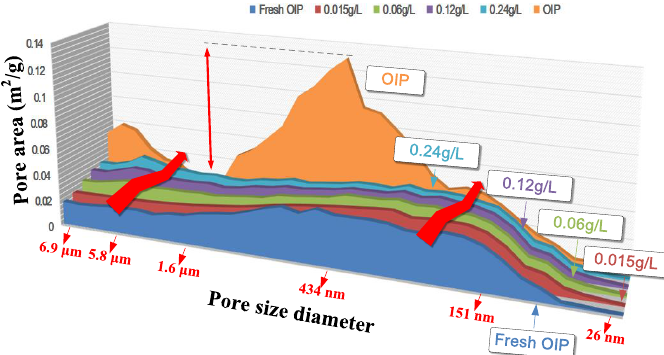
Figure 21. Diameter distribution of micro pores in OIP and NOIP.